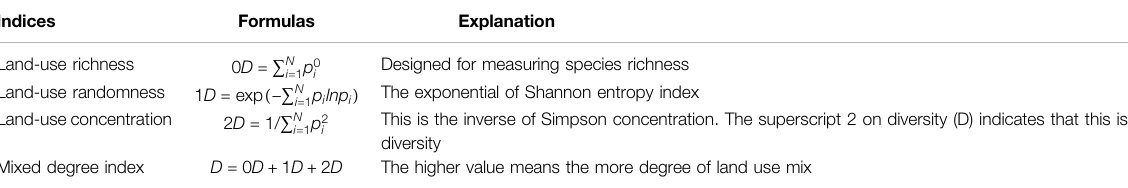
TABLE 2 | Measurement of mixed degree